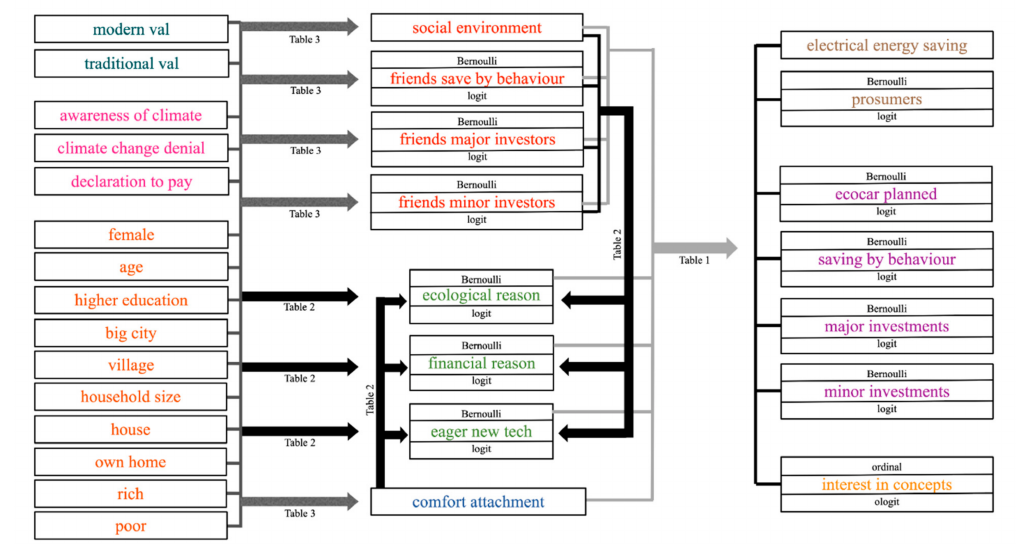
Figure 2. GSEM path